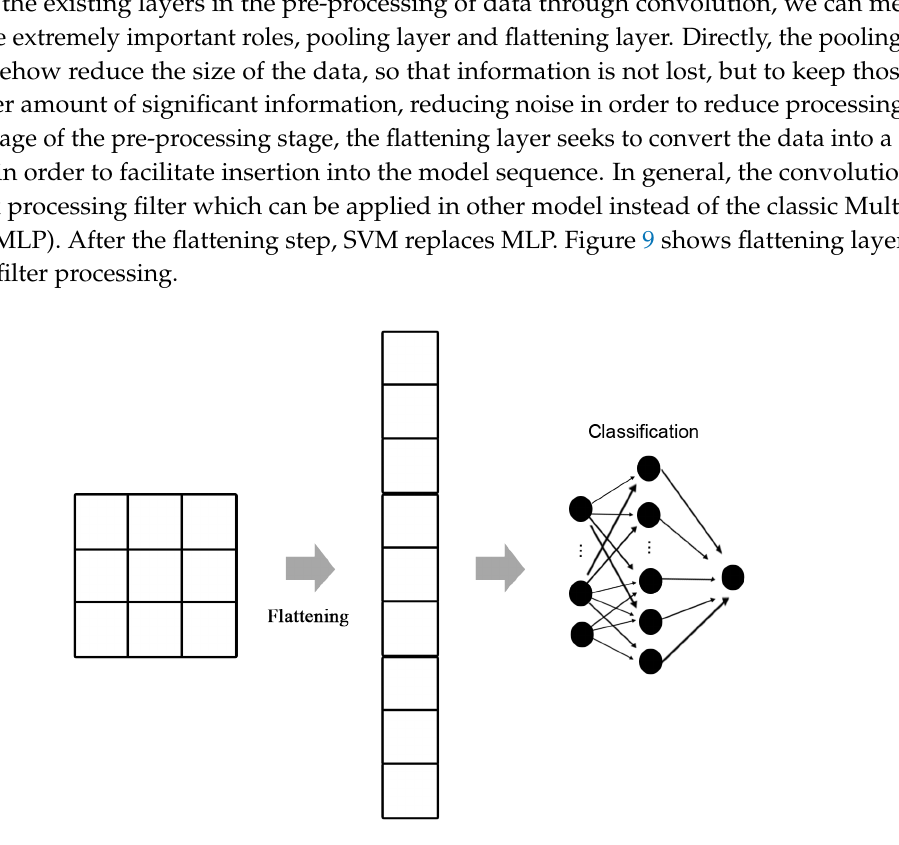
Figure 9. Representation of a flattening layer. Source: adapted from [52] and prepared by the authors.